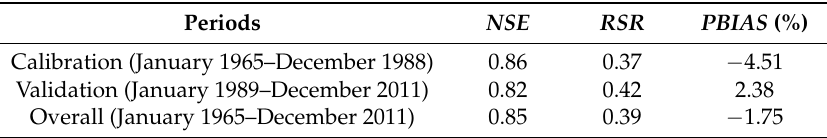
Table 3. Monthly streamflow (m 3 · s − 1 ) calibration and validation results for Yarkant River Basin (YRB), Northwest China. NSE : Nash–Sutcliff Efficiency; RSR : Root mean square error-observations standard deviation ratio; PBIAS : percentage